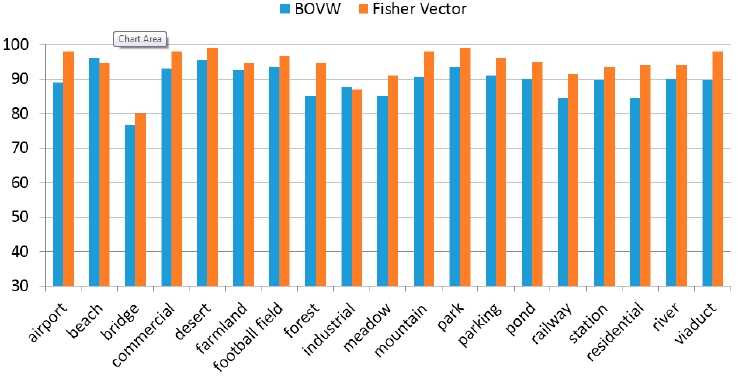
Figure 13. Per-class accuracy (%) of the proposed method and MS-CLBP+BOVW on the 19-class satellite scene dataset.